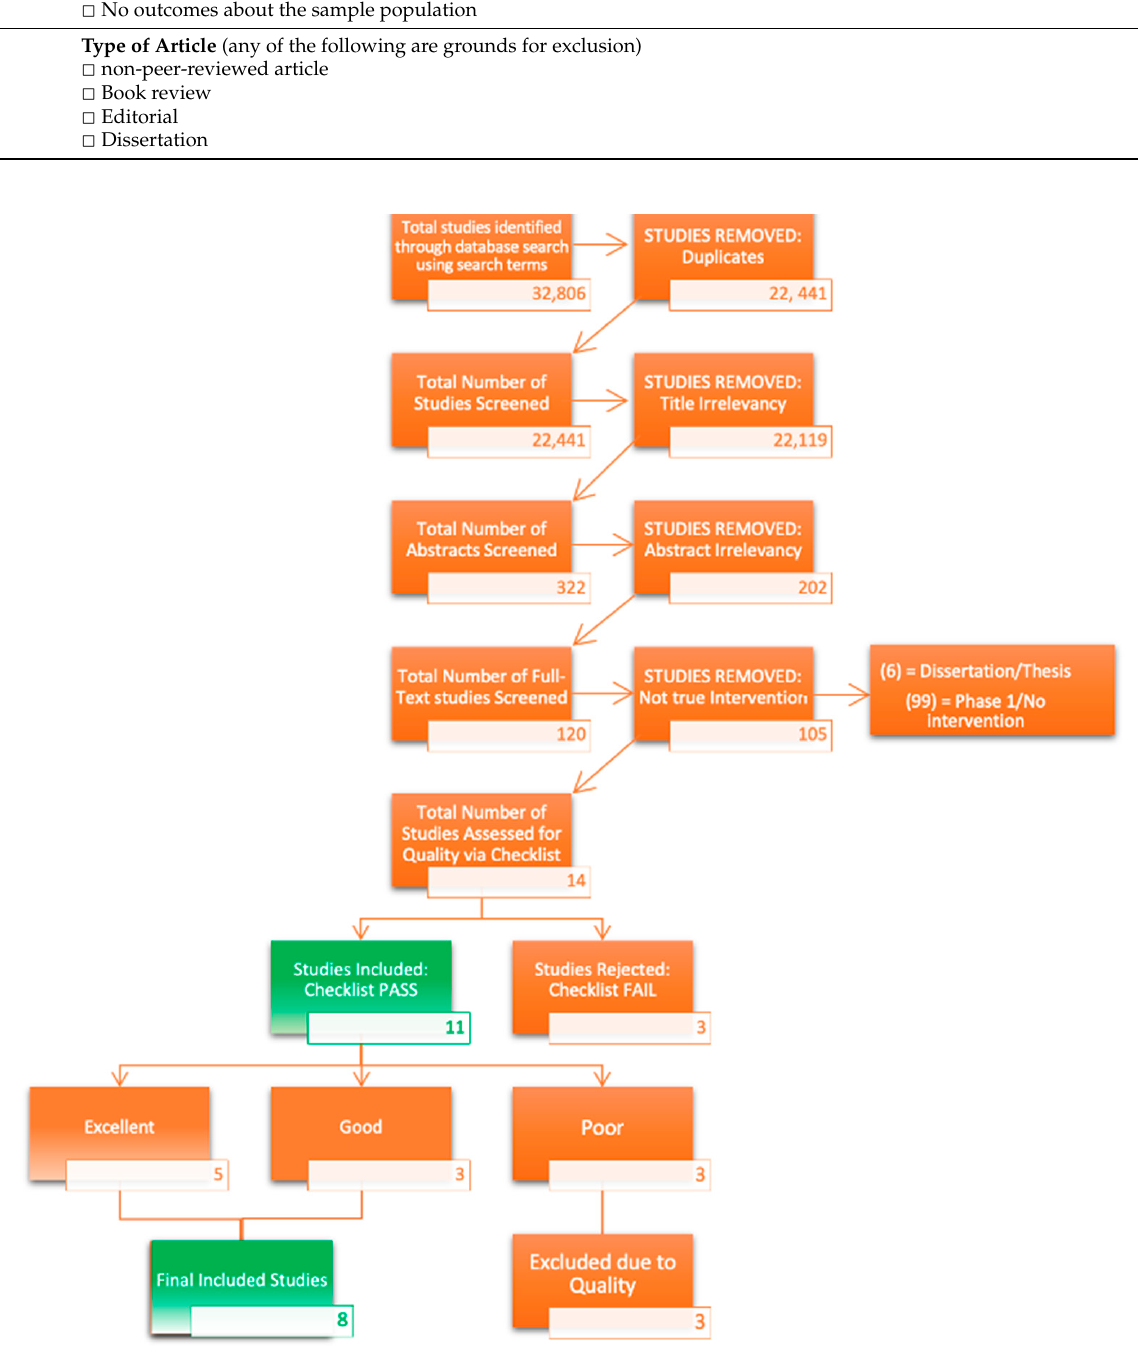
Figure 2. Interventions Systematic Review Flowchart.